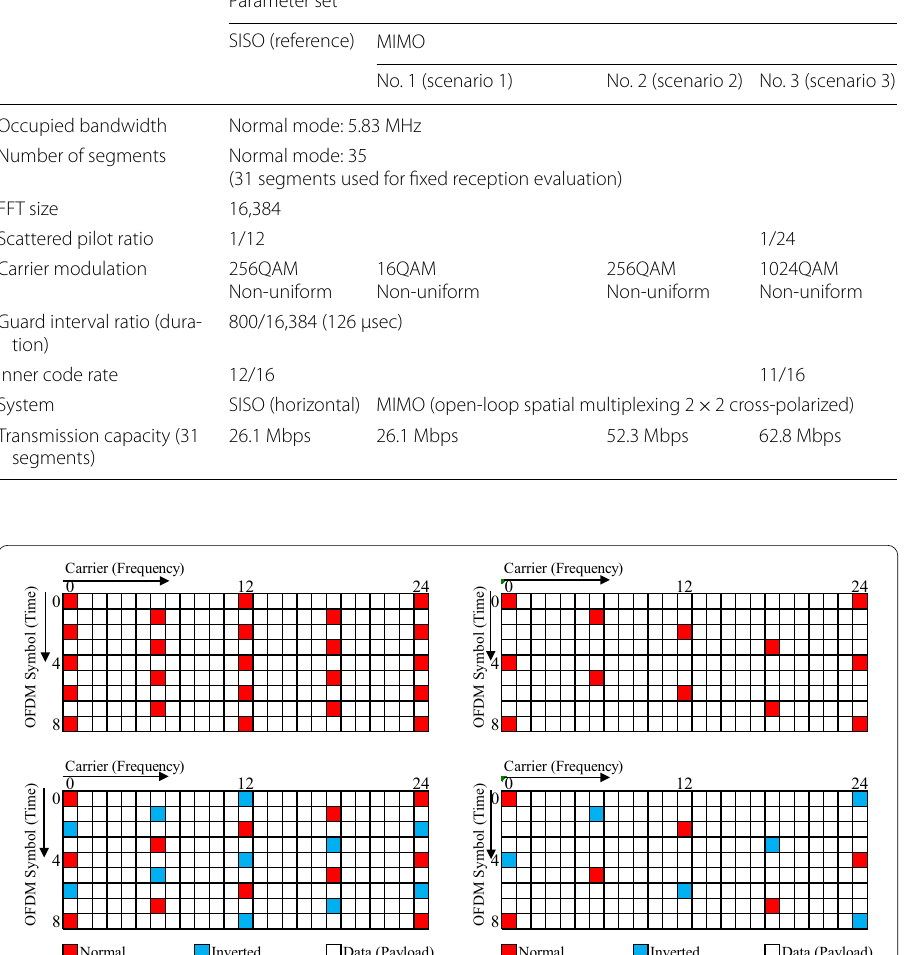
6, Dy 2 (left) and Dx 6, Dy 4 (right). For SISO (top) and = = = =